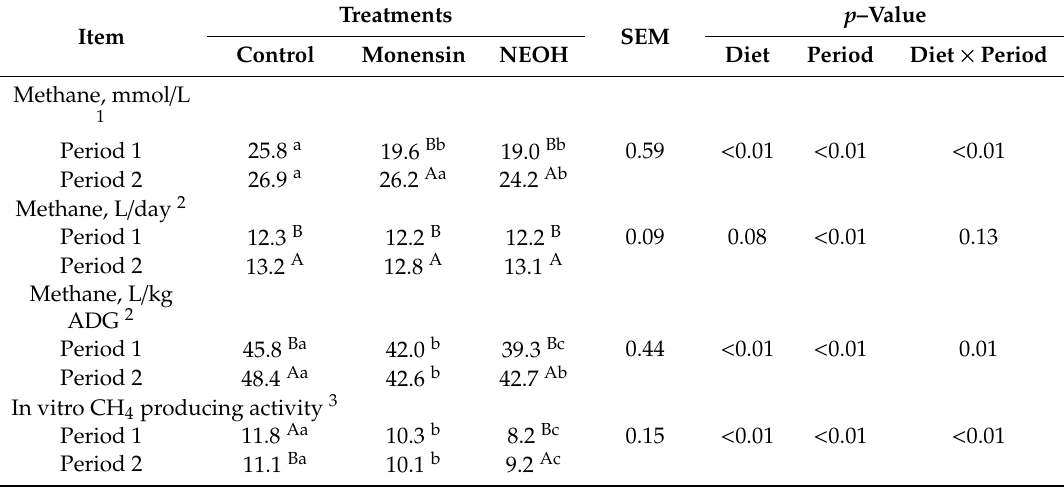
Table 5. Supplementation e ff ects of monensin and nitroethanol (NEOH) to lamb diet in feeding